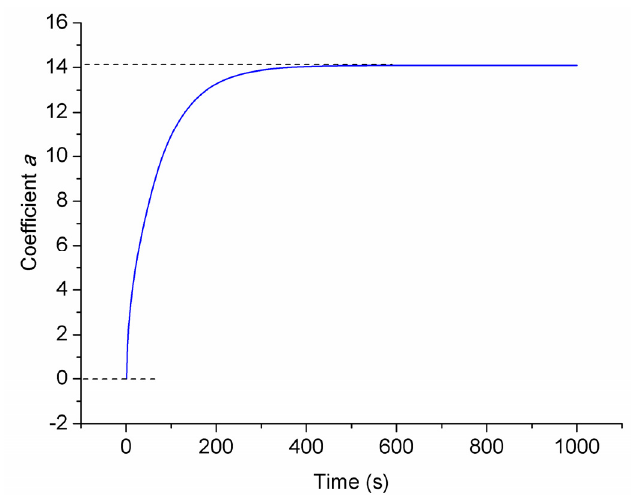
Figure 6. Changes of the coefficient a with